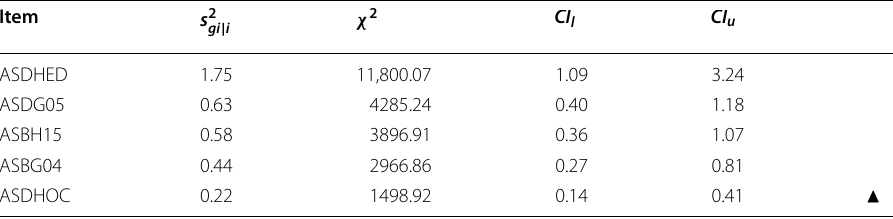
Table 6 Variance of the discrimination parameter c gi across countries (given item i ), χ 2 -value and asymmetric confidence interval ( CI l lower bound, CI u upper bound; items ordered in descending order of s 2 gi | i